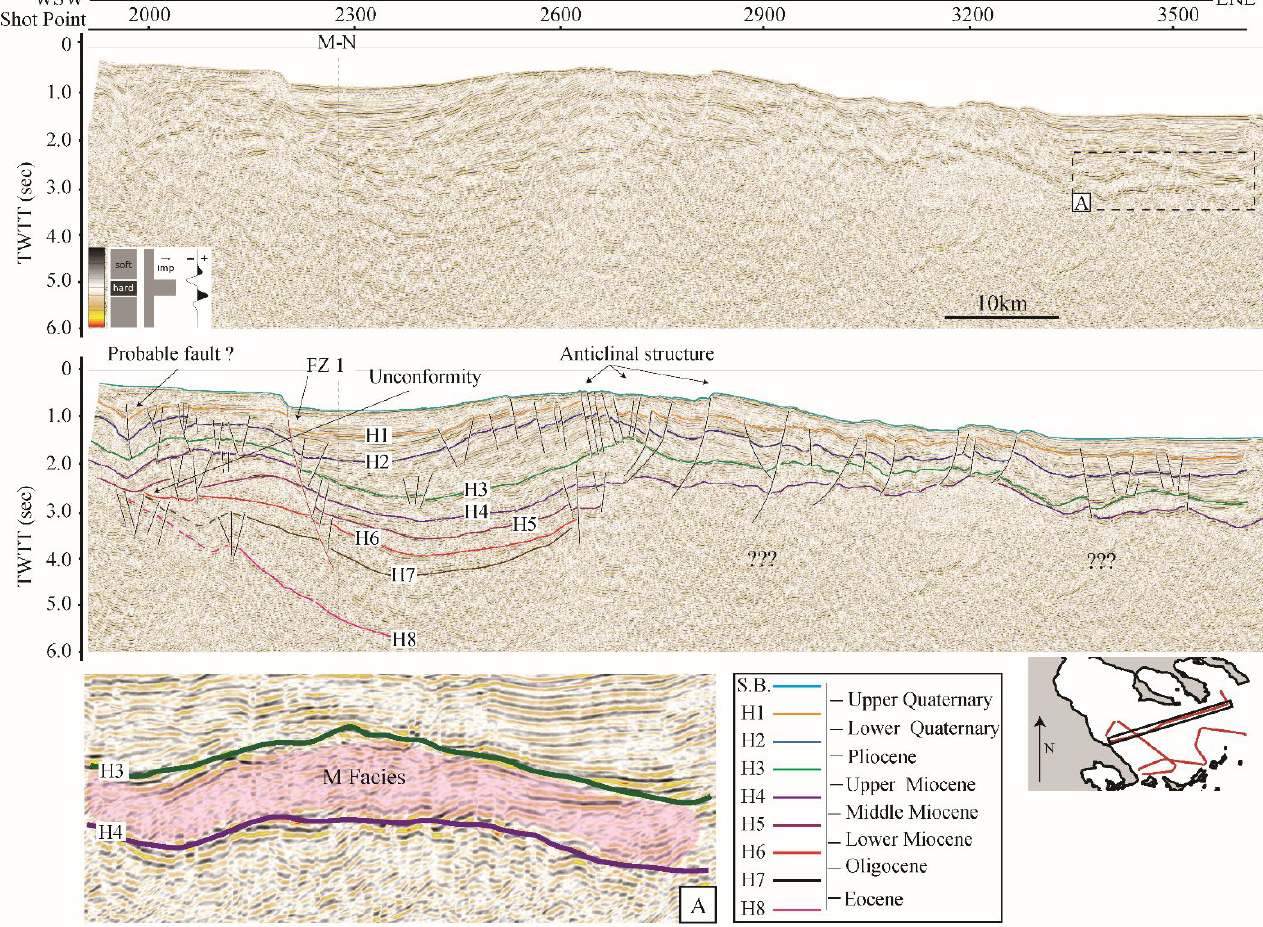
Figure 7. Seismic line OP. Upper part: un-interpreted regional seismic profile. Lower part: interpreted seismic section with highlighted key horizons and the most prominent tectonic elements. ( A ) Differentiated seismic signature of SU.4 characterized by M facies (color-shaded area).